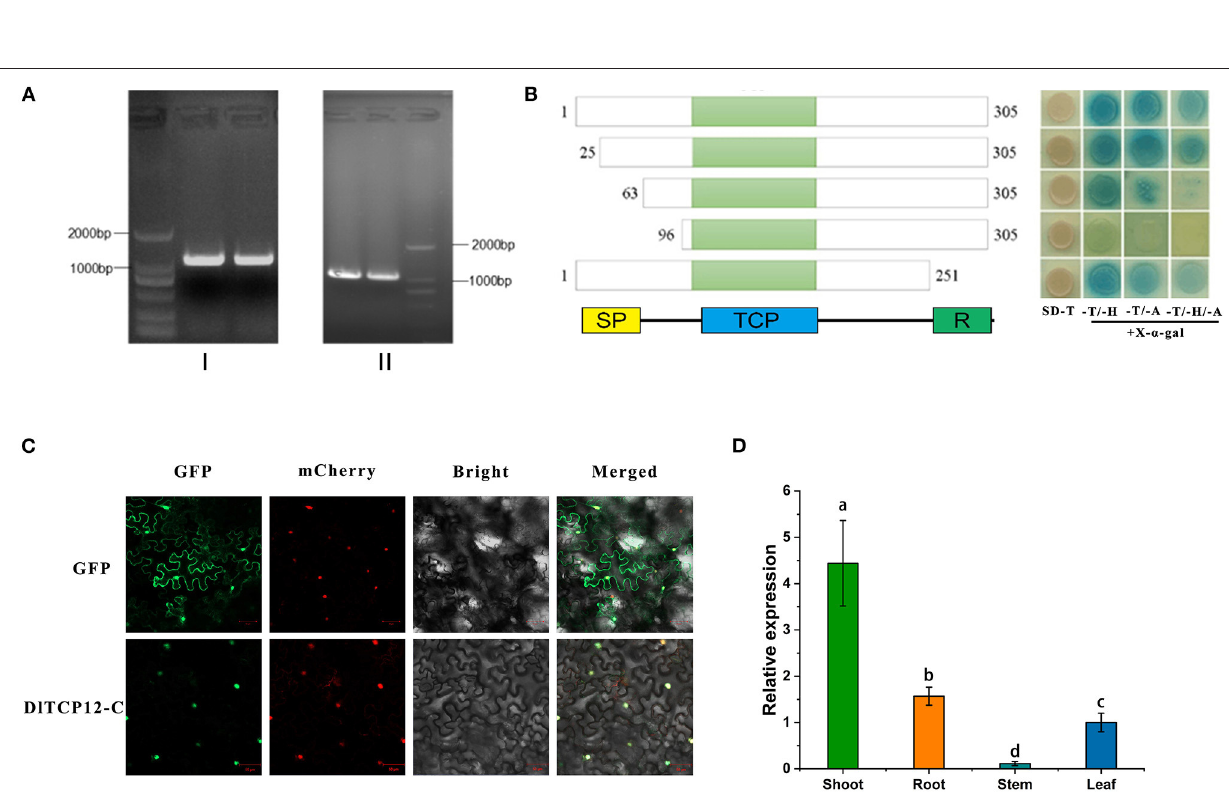
Frontiers in Plant Science |